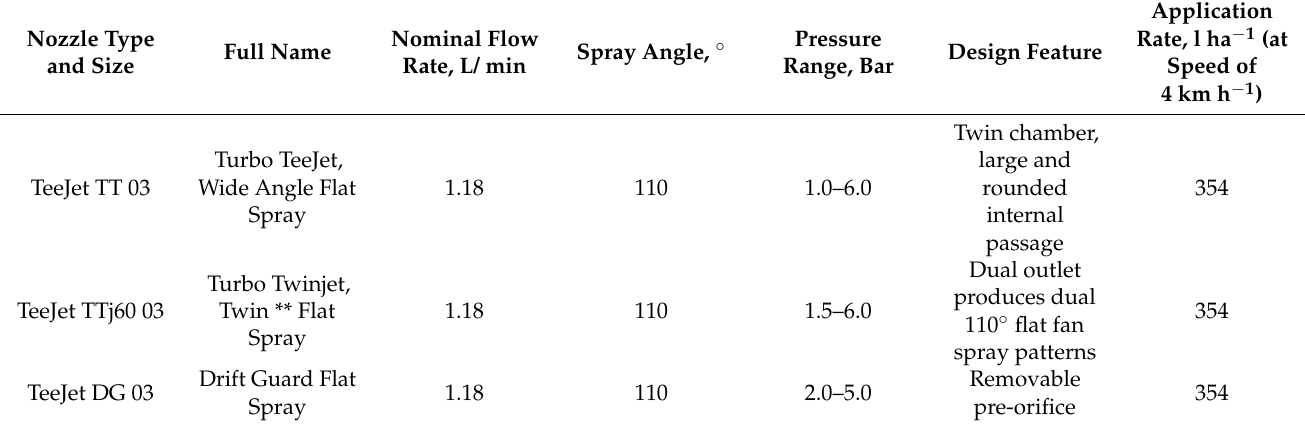
Table 1. Features of the nozzles used in the study *.